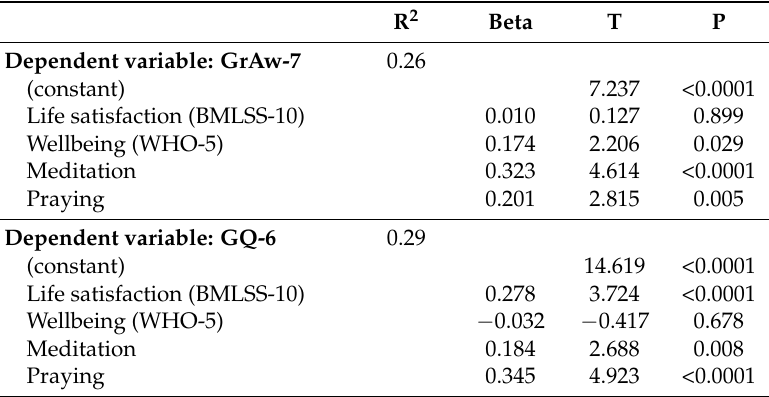
Table 4. Regression